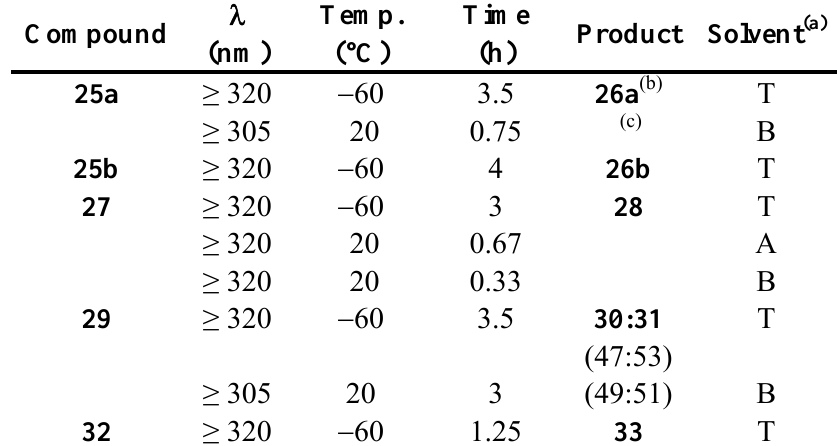
Table 1. Experimental conditions and results for the photolysis of alkylidenedihydrotetrazoles 25 , 27 , 29 and 32 . The conversions and the yields were higher than 95%, except for the cases referred on the